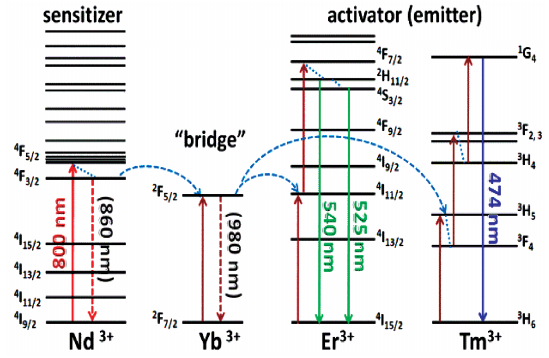
Figure 2. Upconversion process of Nd/Yb/Er(Tm) tri-dopants system with 800 nm excitation. Reproduced with permission from [12]. Copyright John Wiley & Sons,